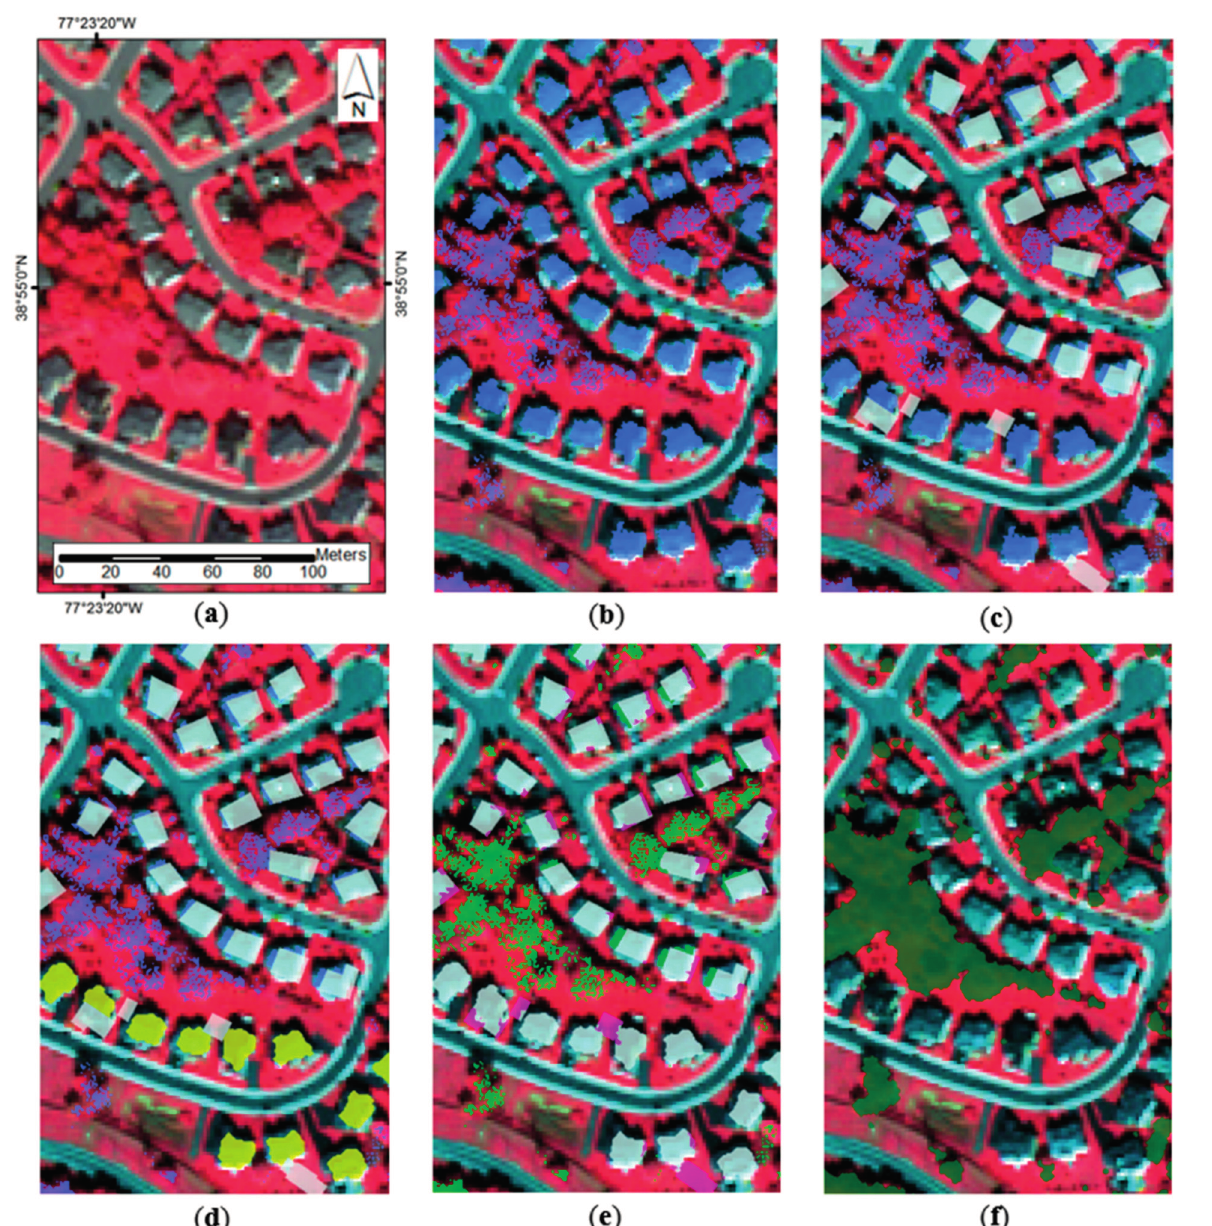
Figure 5. Segmentation workflow for tree canopy mapping using a combination of an nDSM and multispectral data. ( a ) 2-m GSD 8-band WorldView-2 imagery for the Fairfax County region, Virginia, USA. ( b ) Initial segmentation of tall objects (temporary class _Temp , in blue) using an nDSM. ( c ) Incorporation of thematic building footprints (white objects). ( d ) Classification of missing buildings using spectral, shape, and size criteria (yellow objects). ( e ) Evaluation of tree canopy overhanging buildings (draft tree canopy in light green, buildings in white, potential overhanging tree canopy in magenta). ( f ) Final Tree Canopy class after error checking and morphological